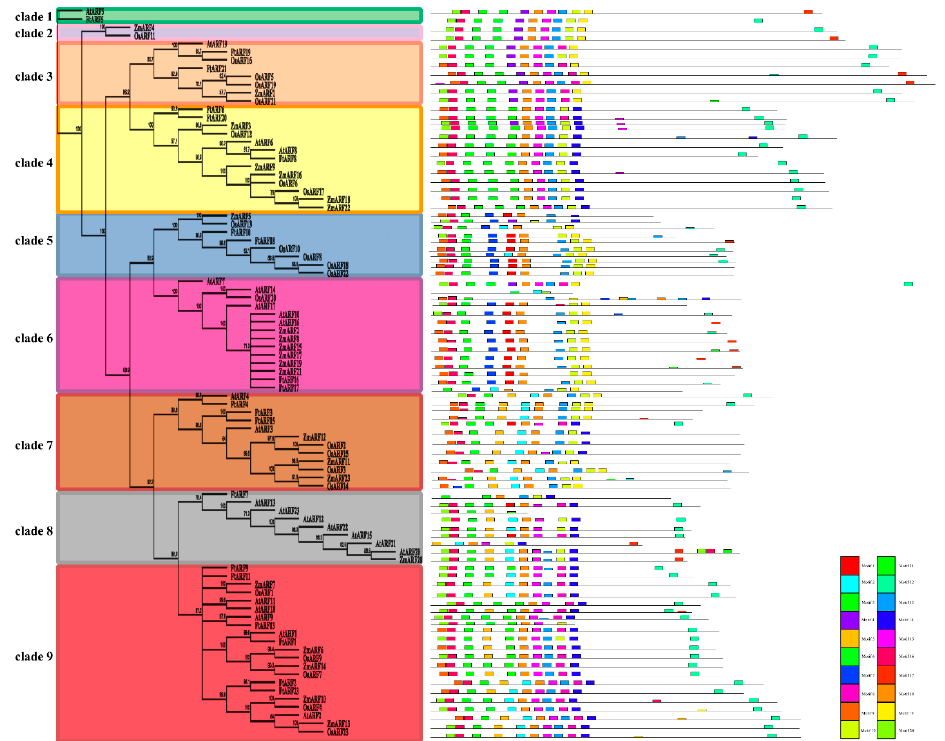
Figure 2. Phylogenetic relationships and motif compositions of ARF proteins from four different plant species. Left panel: an unrooted phylogenetic tree constructed using Geneious R11 with the neighbor-joining method. Right panel: distribution of conserved motifs in ARF proteins. The different-colored boxes represent different motifs and their position in each ARF protein sequence.